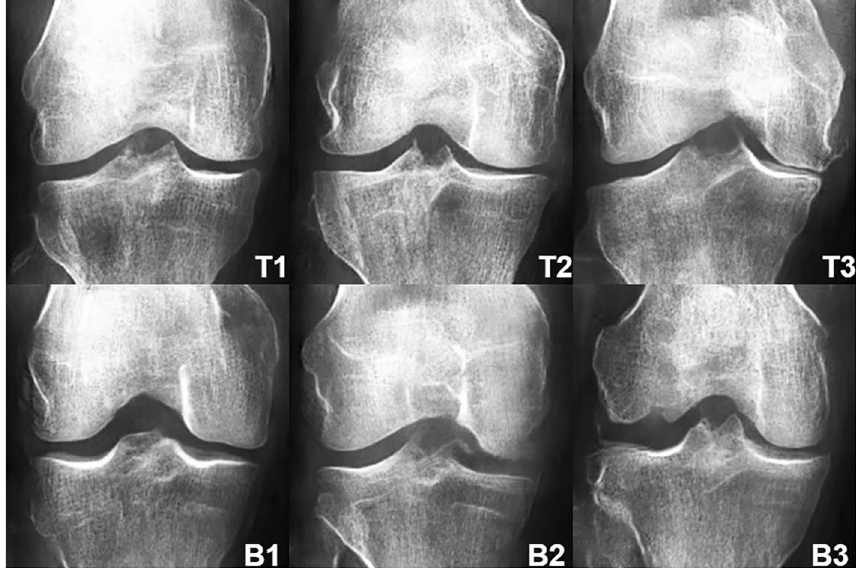
Figure 3. DeepFake top and bottom examples as a function of experts confused, T1 confused 85.71% of experts, T2 73.33%, T3 71.43%, B1 0%, B2 and B3, 13.33% each. Refer to Fig. 6 for interpretation assistance of the KL criteria amongst these images.